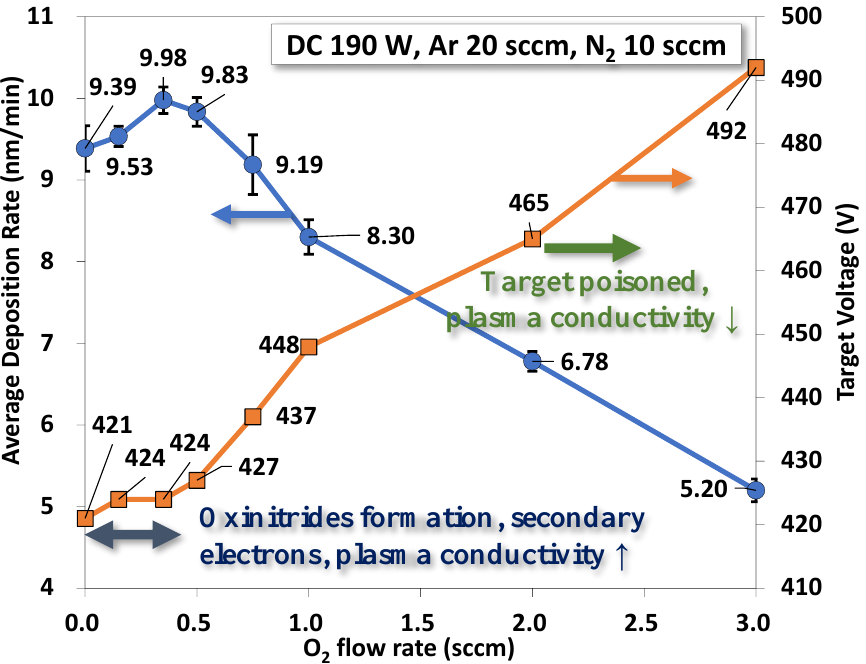
Figure 1. Variations of the average deposition rate, the target voltage for films deposited under N 2 = 10 sccm, and different oxygen flow rates. (Colored lines: average deposition rate, target voltage). The initial rise of the deposition rate between 0 and 0.35 sccm O 2 supply can be